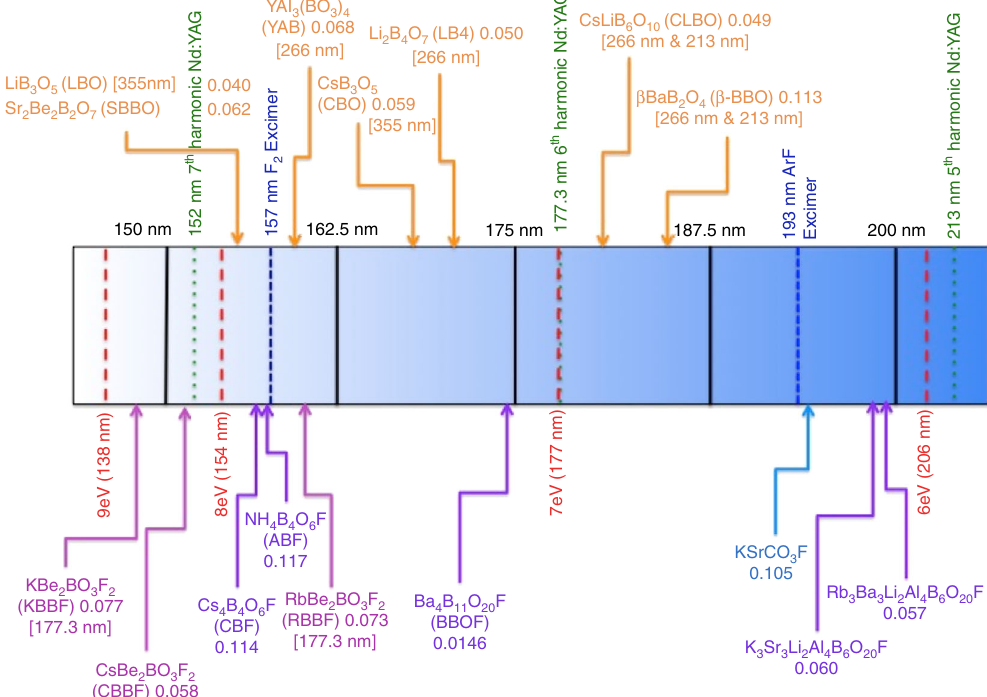
Fig. 1 Deep-UV nonlinear optical materials. Deep-UV spectrum from ∼ 225 nm to 125 nm depicting the absorption edges of some NLO materials, along with excimer wavelengths F 2 and ArF (blue dashed lines), 5th, 6th, and 7th harmonics of Nd:YAG: 1064 nm (green dotted line), and energies at 6, 7, 8, and 9 eV (red dashed lines). The arrows denote the absorption edge for each material, where the numbers in square brackets are the wavelengths where coherent radiation from a fundamental 1064 nm source is reported. The birefringence is given after the compound. See ref. 10 for the birefringence phase-matching condition expressions for uniaxial and biaxial crystals. Beryllium-containing borates exhibit absorption edges below 175 nm (7.08 eV), 147 nm (8.43 eV), and 160 nm (7.75 eV) for KBBF and RBBF respectively, as well as appropriate birefringence values, i.e., 0.080 (at 1064 nm for KBBF) and 0.073 (at 649.3 nm for RBBF) and nonlinear optical d ij constants, 0.47pm/V (KBBF) and 0.45pm/V (RBBF). Adapted from ref.